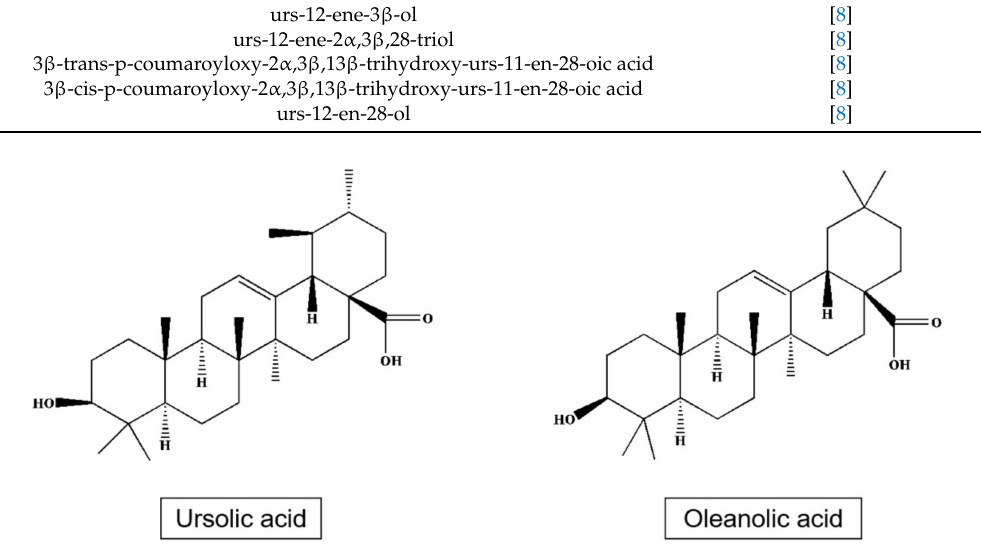
Figure 4. Structures of ursolic acid and oleanolic